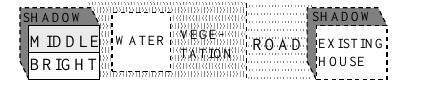
Figure 5. Candidate region types for newly-built building extraction (solid line=candidates, dashed line=non-candidates)